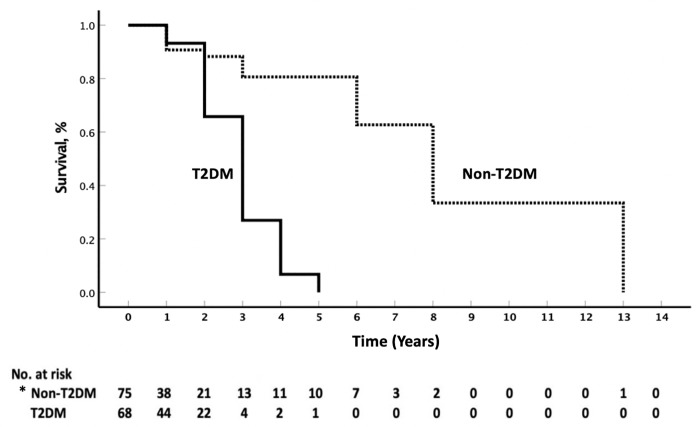
Cumulative survival probability of patients with T2DM or non-T2DM human papillomavirus-16 positive HNSCC.*The T2DM status for 8 patients with HPV-positive HNSCC was unknown. Abbreviations: HNSCC, head and neck squamous cell carcinoma; HPV, human papillomavirus, T2DM; type 2 diabetes mellitus.